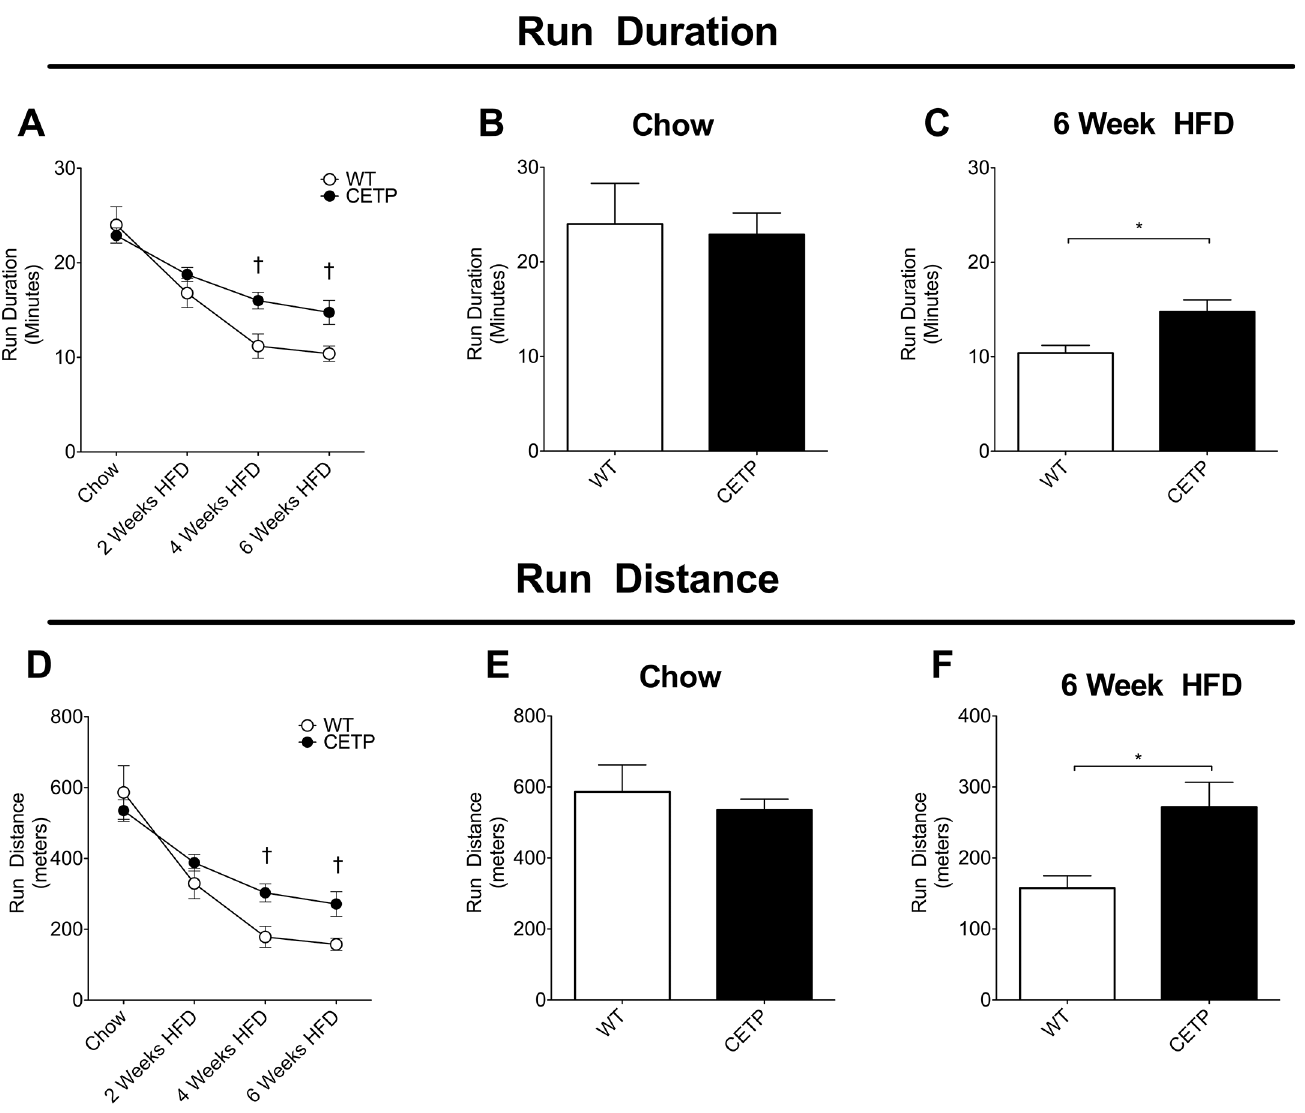
Fig 2. CETP expression improves endurance performance in female mice. (A) Run duration throughout the course of HFD. (B) Run duration in chow-fed mice before switch to HFD. (C) Run duration after 6 weeks of HFD-feeding. (D) Run distance throughout the course of HFD. (E) Run distance in chow-fed mice before switch to HFD. (F) Run duration after 6 weeks of HFD-feeding. Error bars represent mean ± SEM. n = 5 – 8 mice per group. † indicates significance by repeated measures ANOVA with Fisher ’ s least significant difference test. * indicates p < 0.05 by unpaired